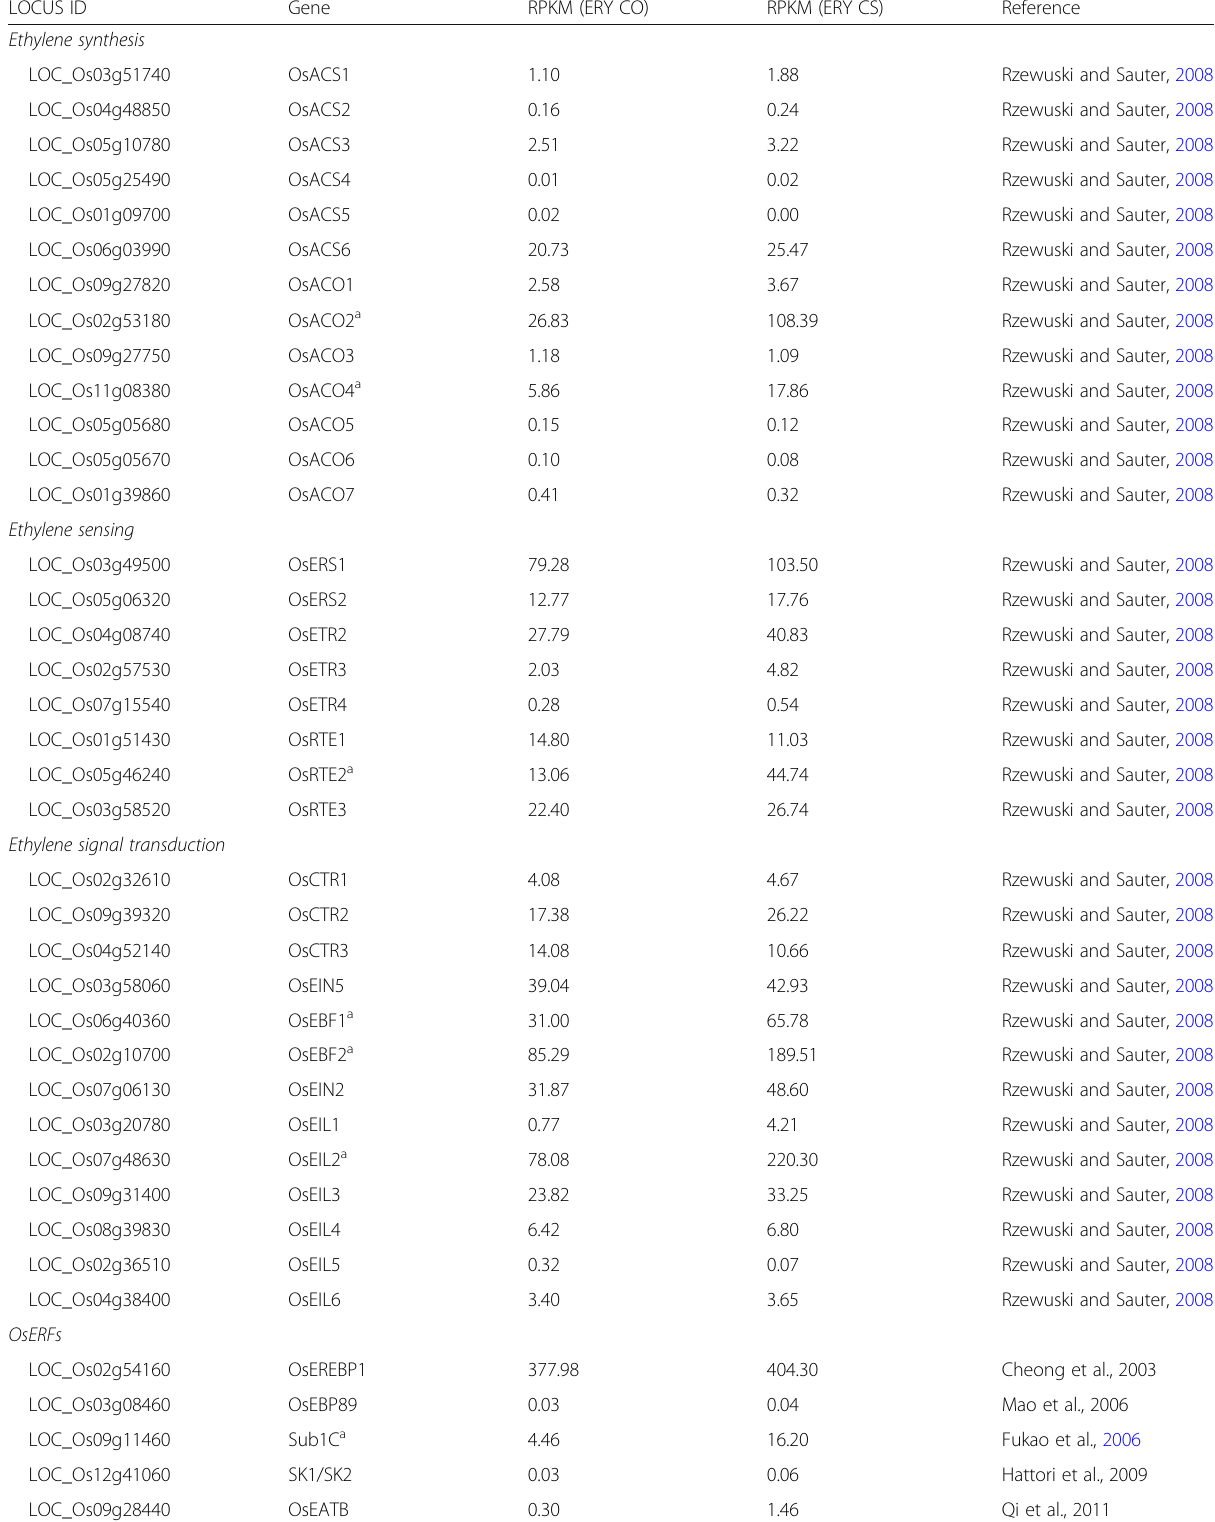
Table 1 Cold-stress responses of ethylene metabolism-related genes in tolerant rice anthers. [this table should be added immediately before